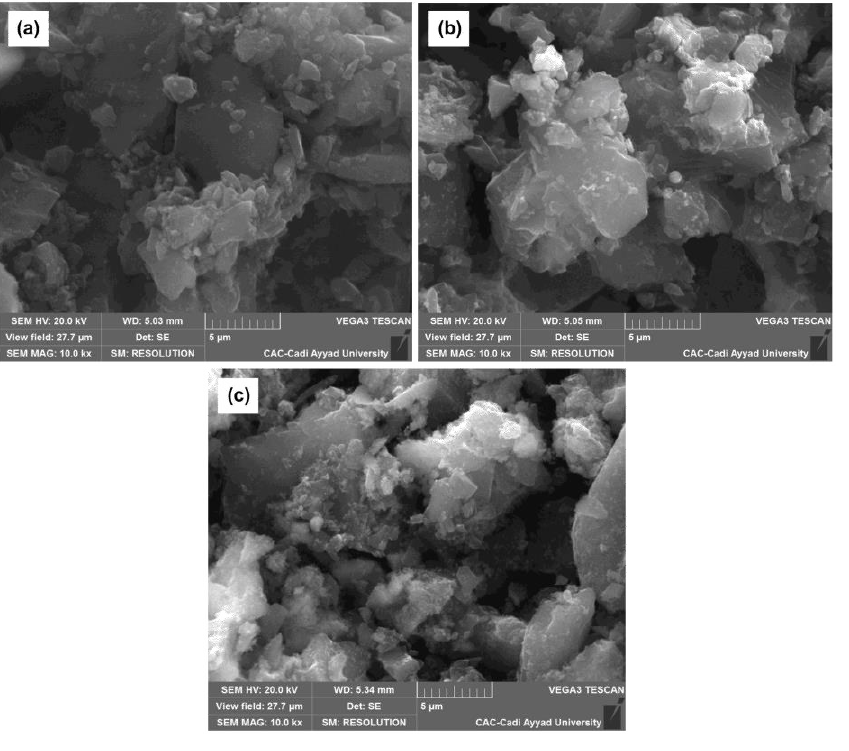
Figure 6. SEM images of PAC ( a ), Fe 3 O 4 -PAC ( b ), and Cu-Fe 3 O 4 -PAC ( c ).